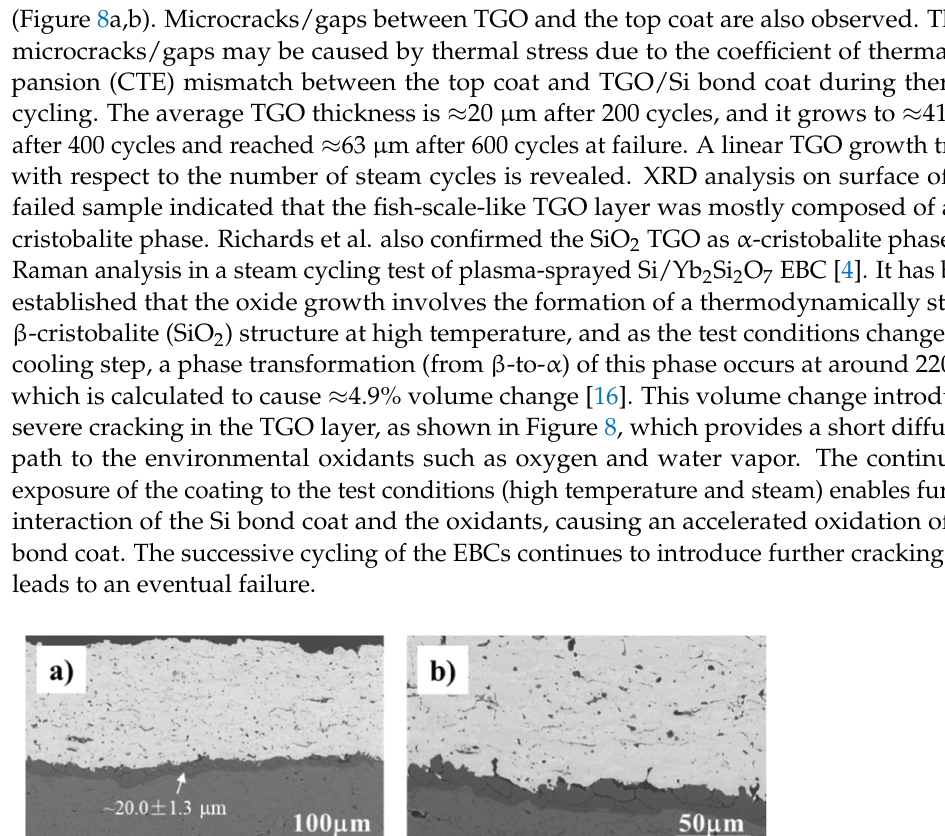
Figure 9. Microstructures of LPPS EBCs for various steam cycles. ( a ) 200 cycles; ( b ) 400 cycles; ( c ) 600 cycles; ( d ) 800 cycles; ( e ) 1000 cycles; ( f ) Top coat cross-section microstructure after 1000 cycles at 1316 °C in 90% H 2 O (g) + 10% air. For LPPS EBCs, a thin and dense SiO 2 TGO layer is observed for all samples at vari- for APS EBC) after 200 cycles, and it gradually grows to ≈ 2.1 µm after 800 cycles and then